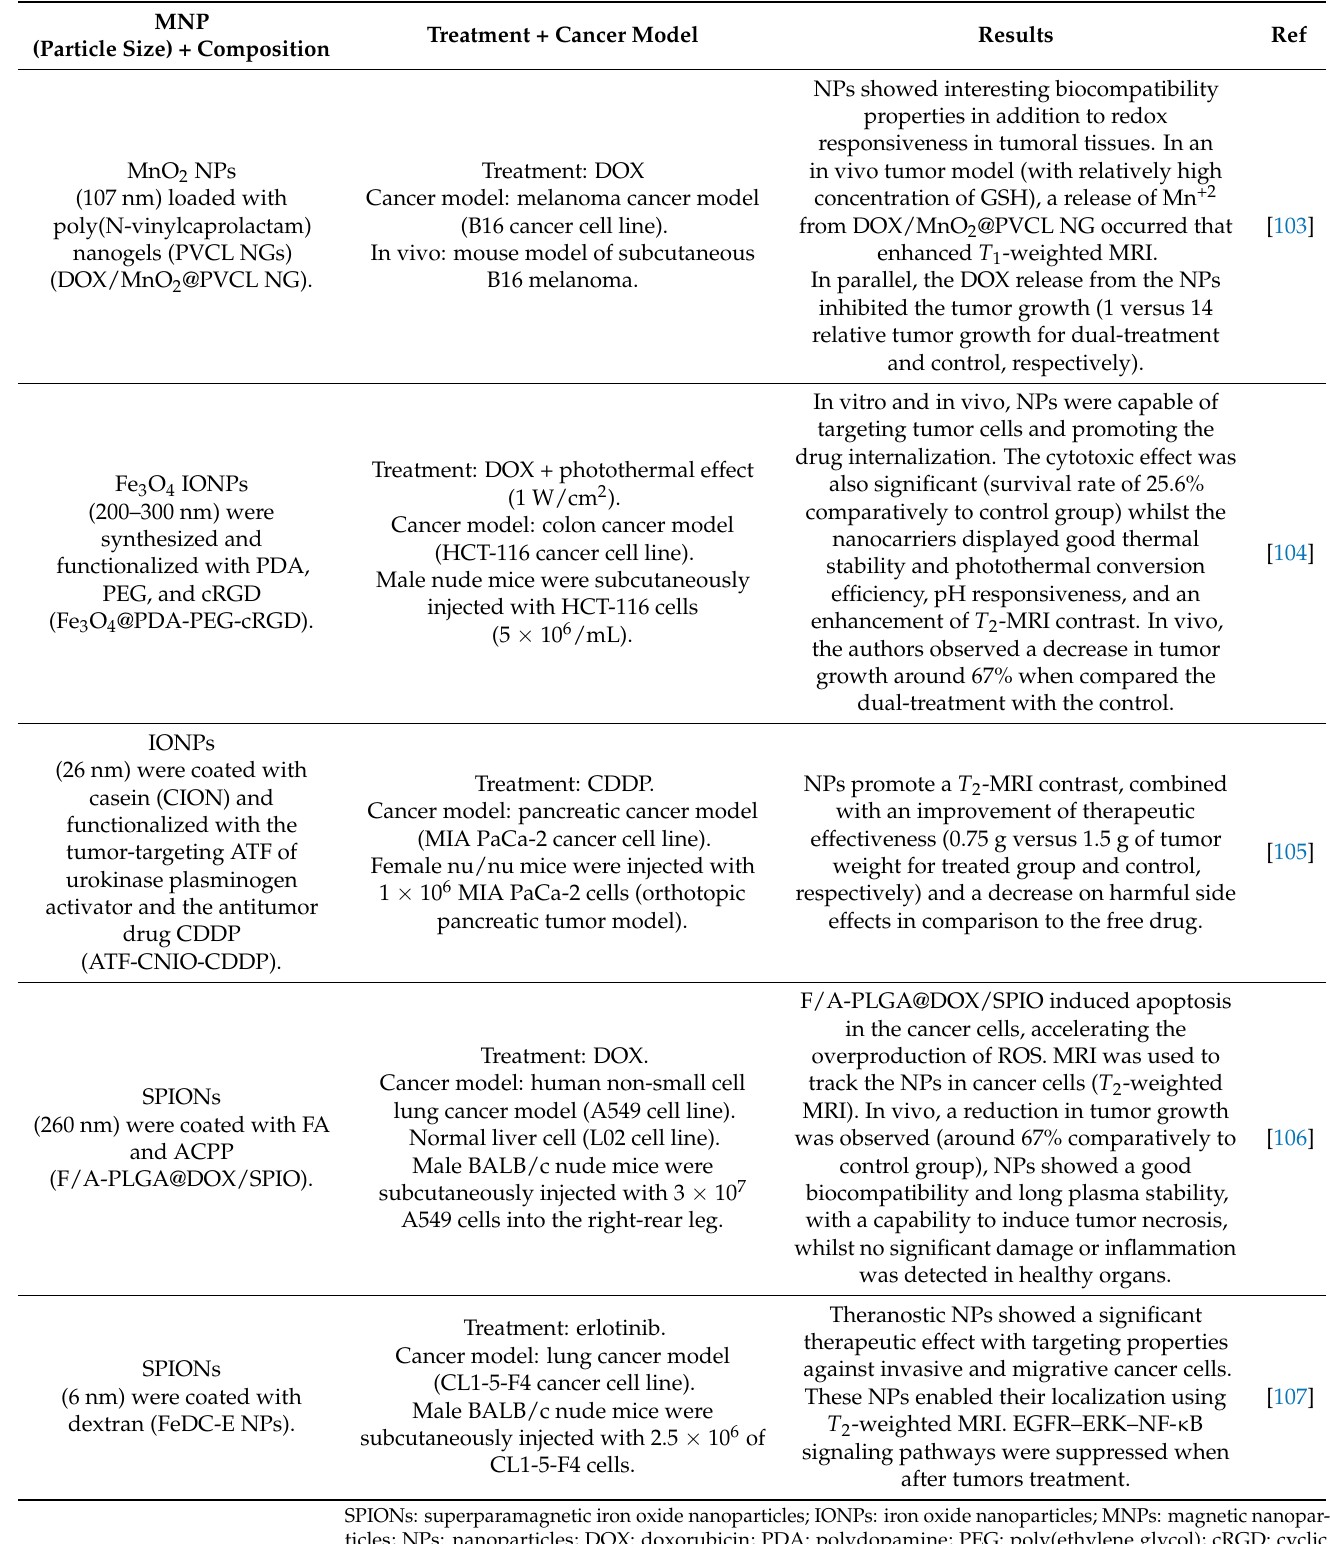
Table 3. Studies using magnetic nanoparticles (MNPs) for cancer